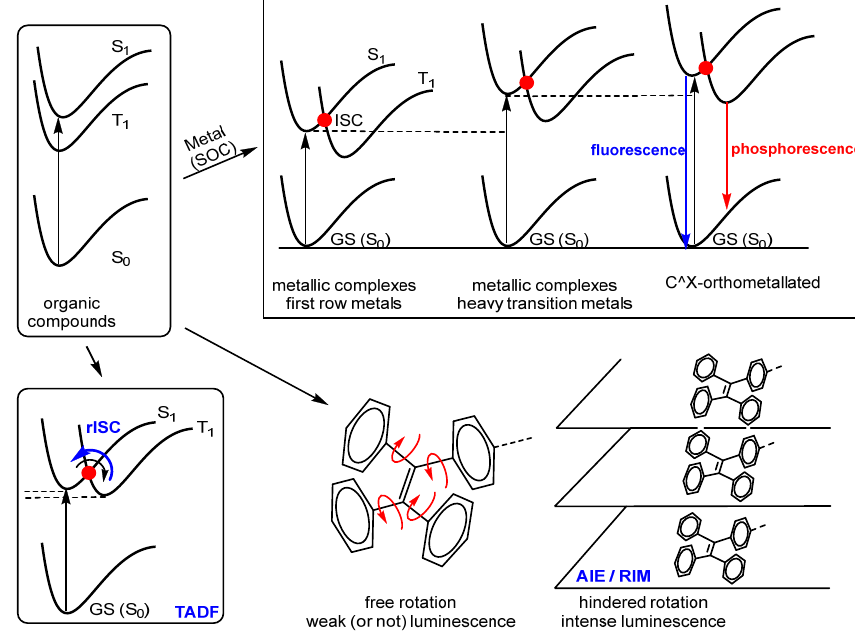
Figure 1. Schematic representation of the old and new concepts presented to recover and amplify the luminescence of transition metal complexes. Adapted from references [27,28] (complexes of the fi rst row metals), [29 − 35] (orthometallation), [36,37] (RIM), [48 − 50] (AIE) and [53 − 56]